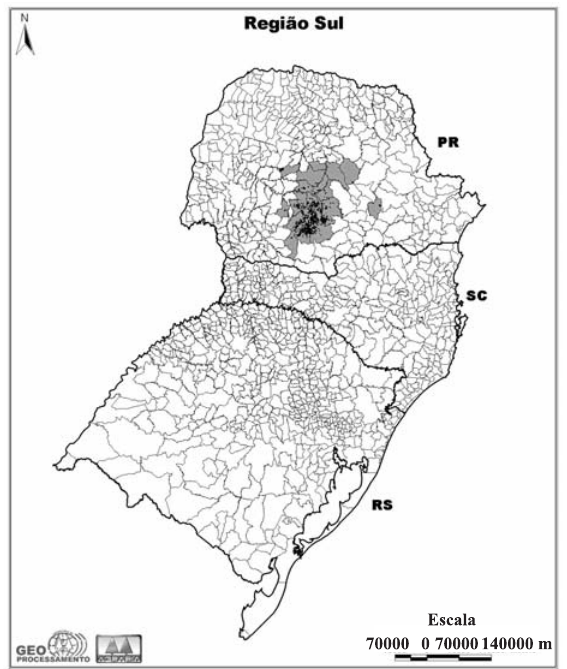
Figura 1. Divisão política (municípios) dos Estados que compõem a região sul do Brasil e localização (em cinza) da região centro-sul do PR, na qual foi desenvolvida a